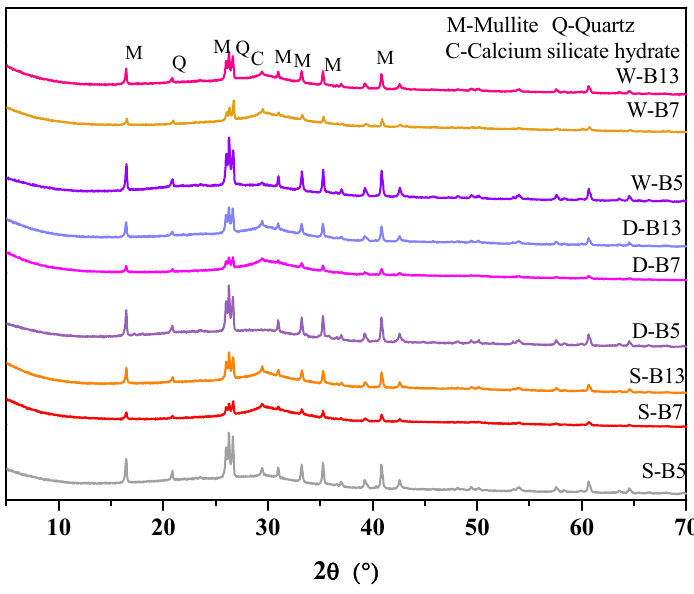
Figure 5. XRD pattern of AA-FASM products under the different curing conditions.